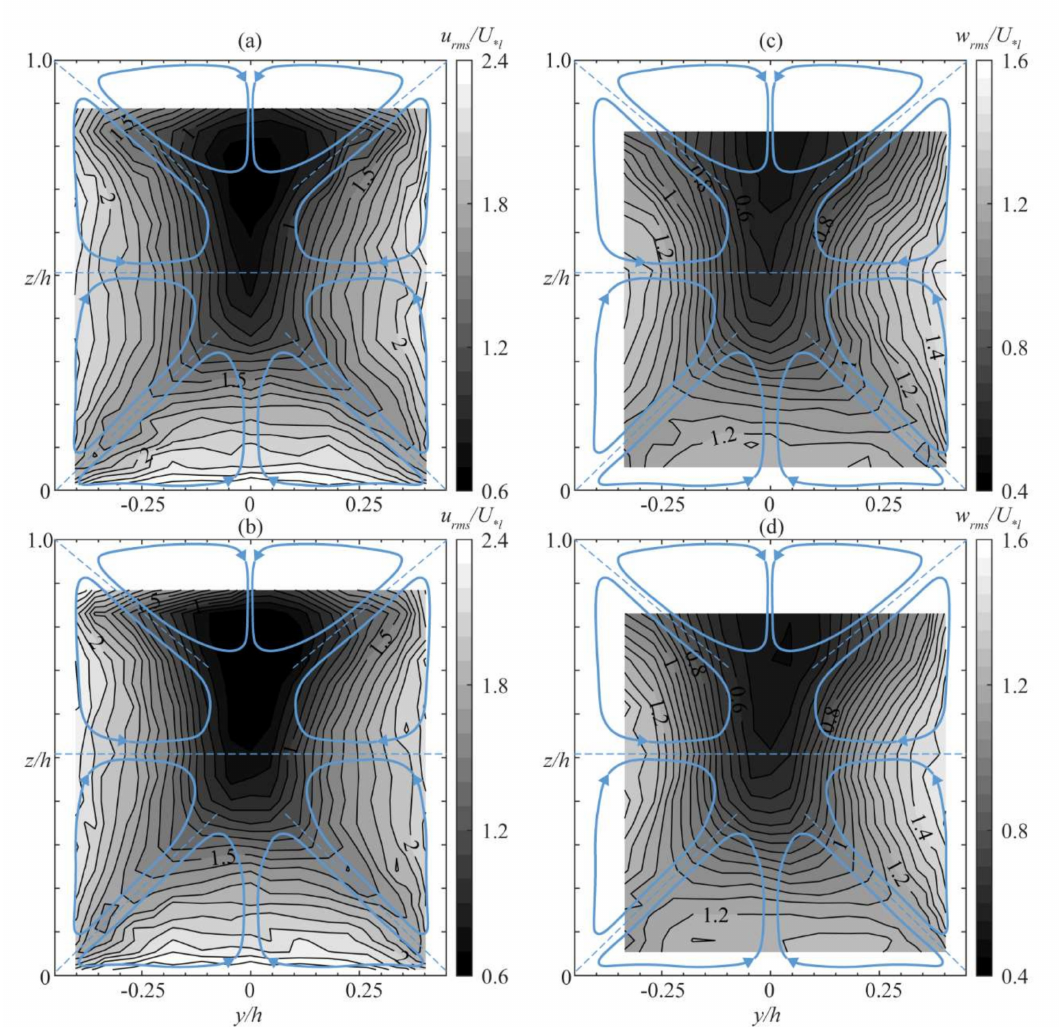
Figure 8. Contour plots of turbulence intensities in ( a , b ) streamwise direction, ( c , d ) vertical direction for TA7 and